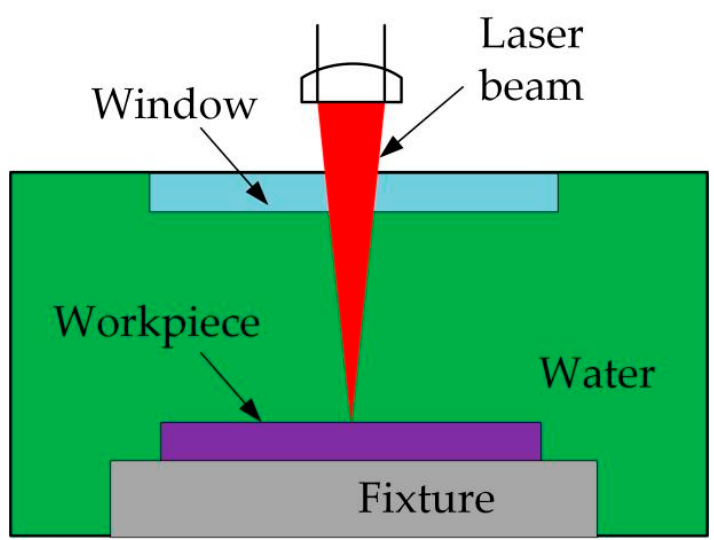
Figure 7. Principle of underwater laser processing.